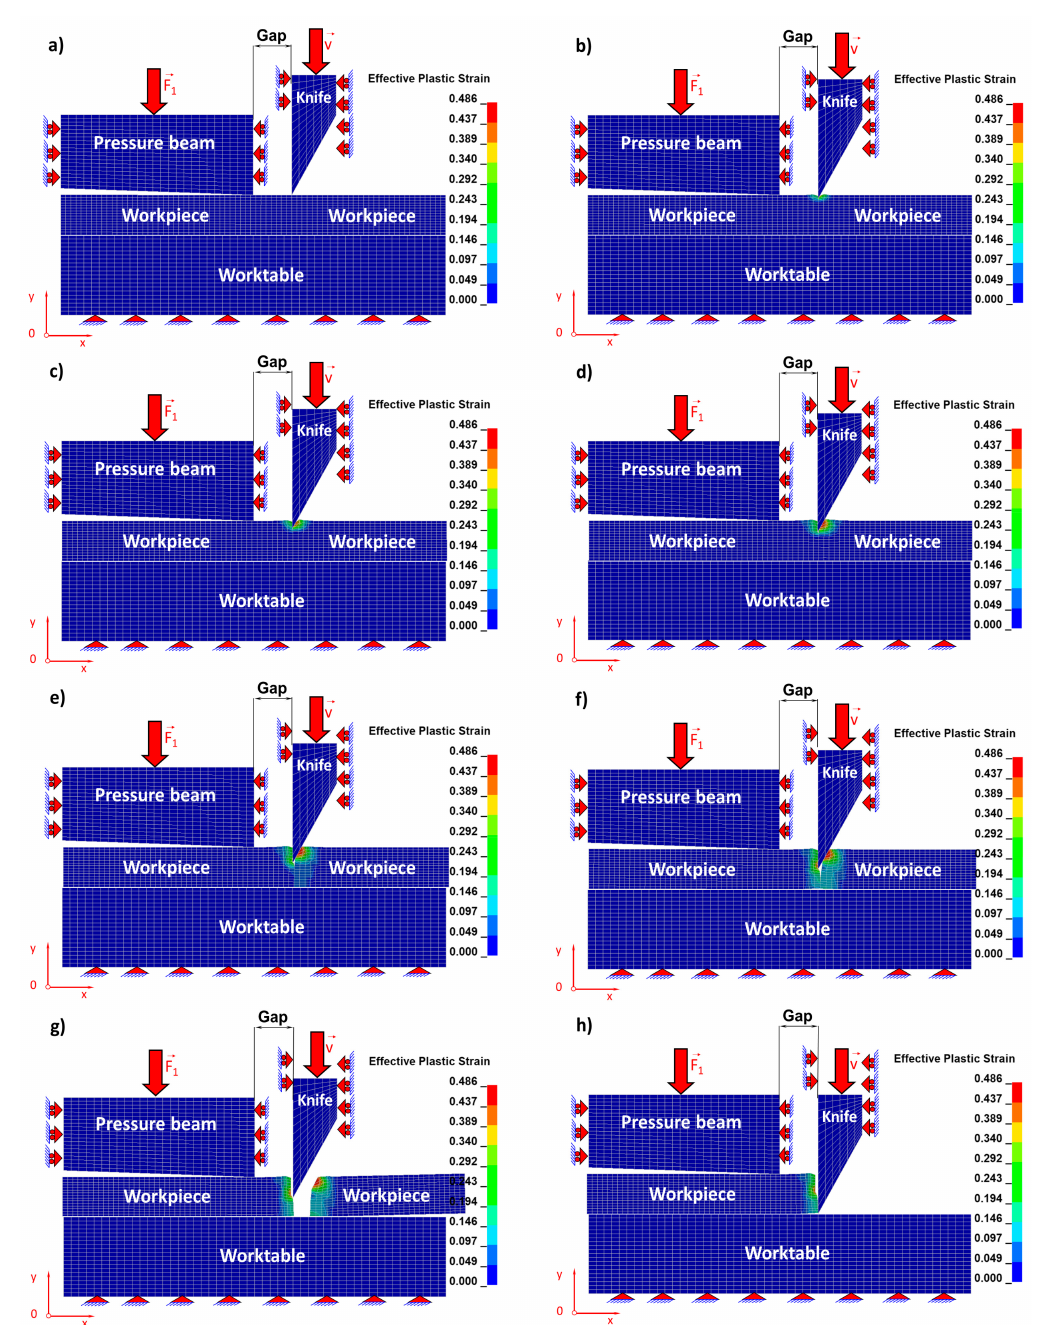
Figure 7. Individual stages of reduced Huber–Mises strains during numerical simulation of a cutting process for selected time instants: ( a ) t a = 2.07 s; ( b ) t b = 3.0 s; ( c ) t c = 4.0 s; ( d ) t d = 5.0 s; ( e ) t e = 6.0 s; ( f ) t f = 7.1 s; ( g ) t g = 7.2 s; ( h ) t h = 12.0